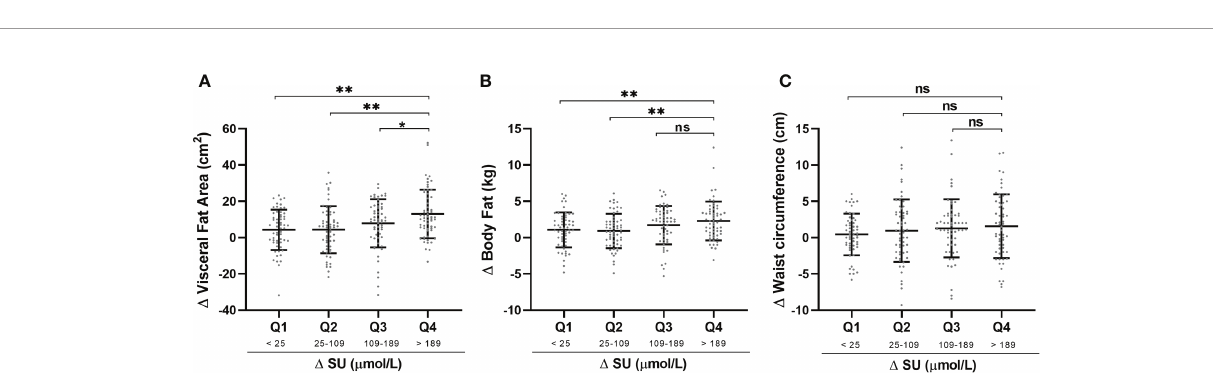
signi fi cant differences between these two urate-lowering agents ( Supplementary Table 1 ).